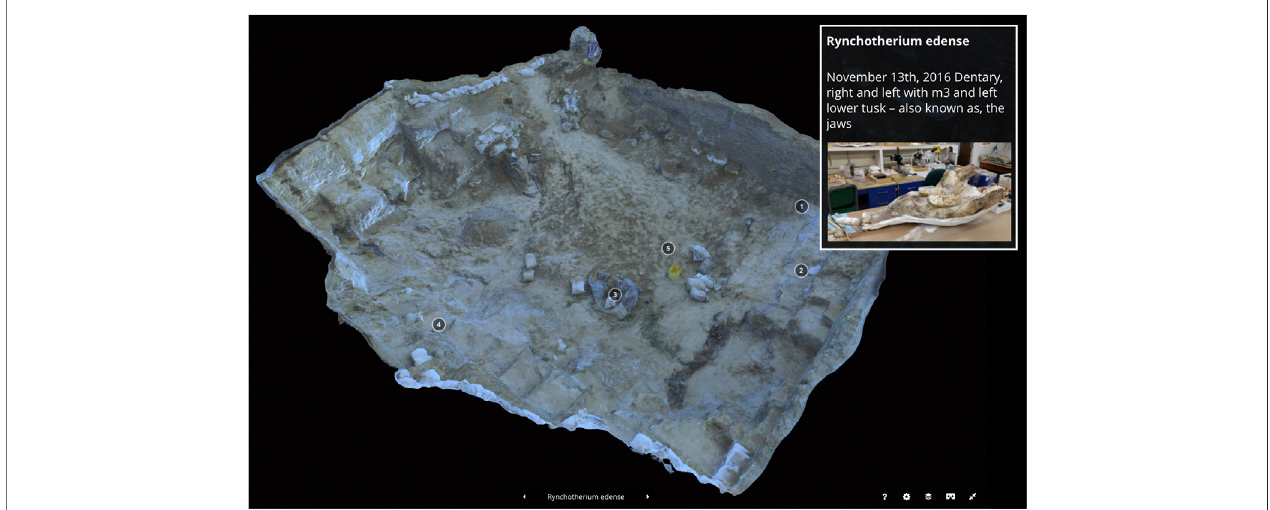
FIGURE 7 | 3D Sketchfab model of a proli fi c fossil site in Florida after the 2016 fi eld season. Additional data issuperimposed onto the 3D model and obtainable by clicking on the numbered plot within the locality. An example of this expandable window features the dentary of the North and Central American proboscidea, Rhynchotherium edense